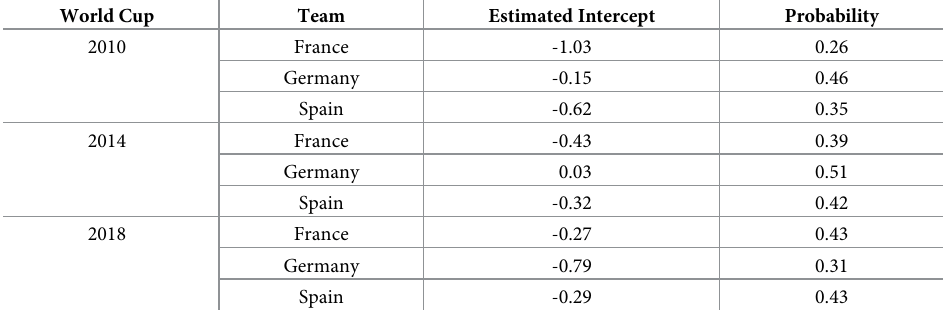
Table 6. Estimated log odds, standard errors, confidence intervals and p-values for shots from possessions that originate in the defensive zone that result in a goal. World Cup